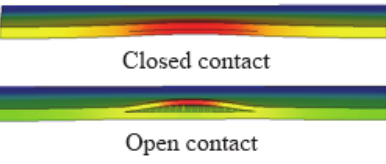
Figure 5: State of the